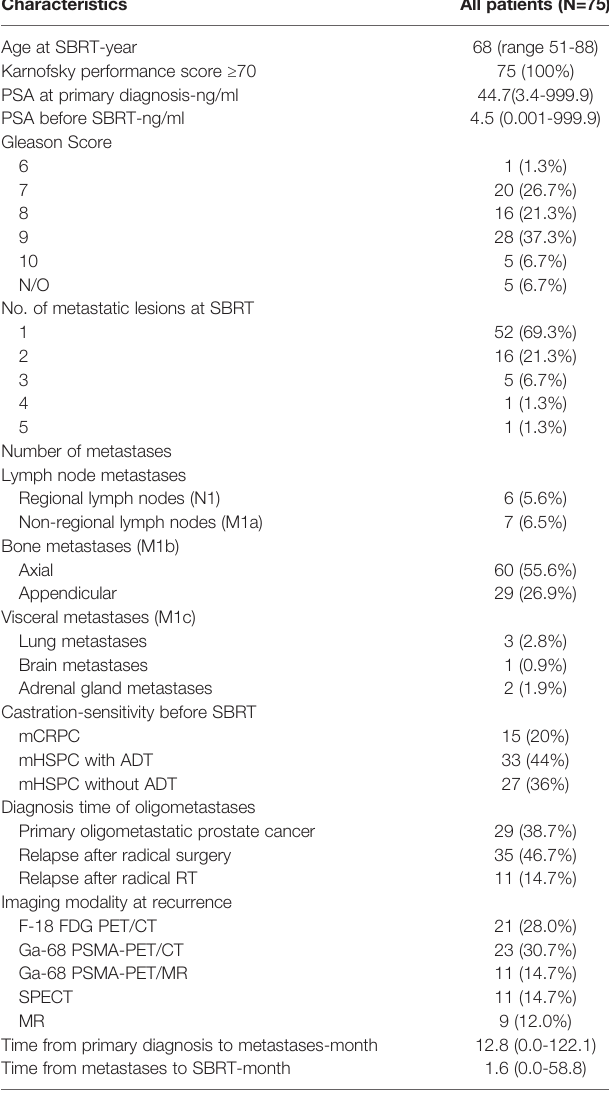
TABLE 1 | Patient characteristics.